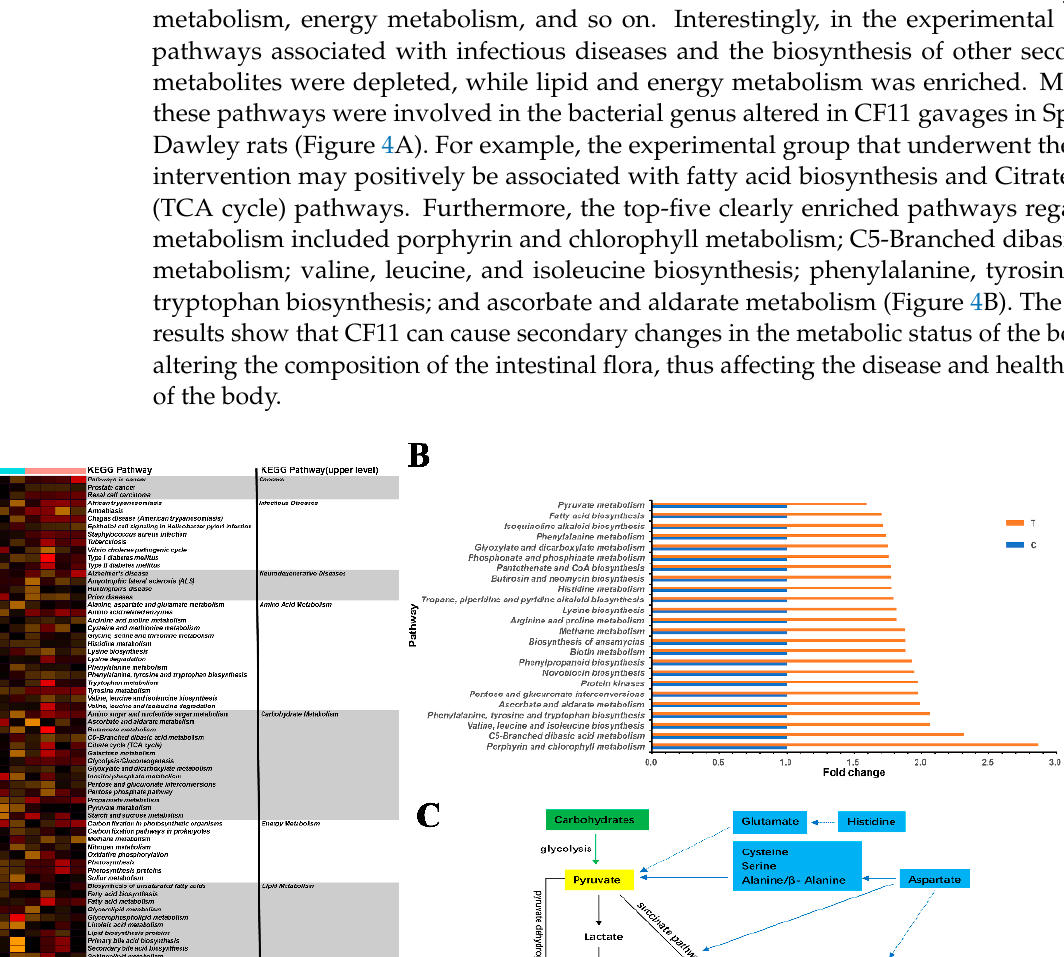
several intermediate steps are involved.